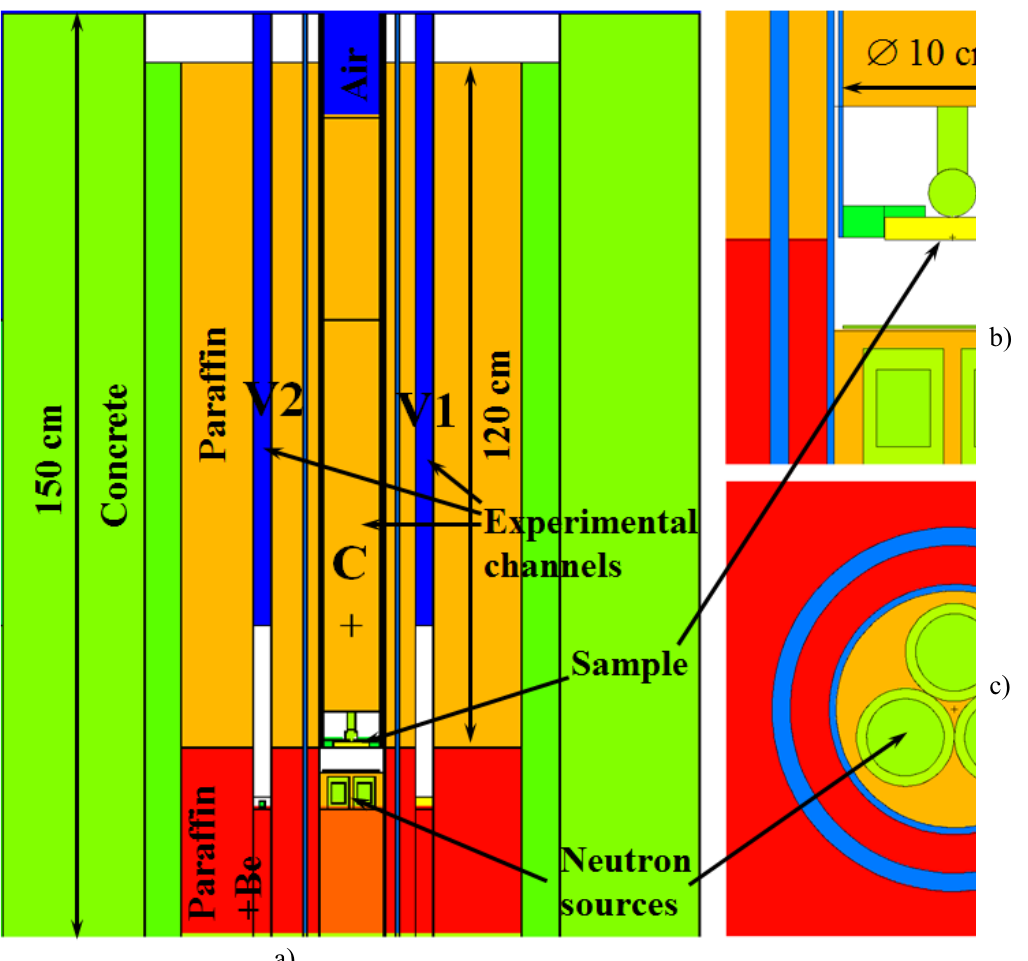
Figure 1. (a) The simplified scheme of the neutron sources container under the ground; (b) vertical view of the central irradiation channel with sample place dedicated for the cells saturated with B irradiation; (c) arrangement of PuBe neutron sources horizontal cut of the central experimental